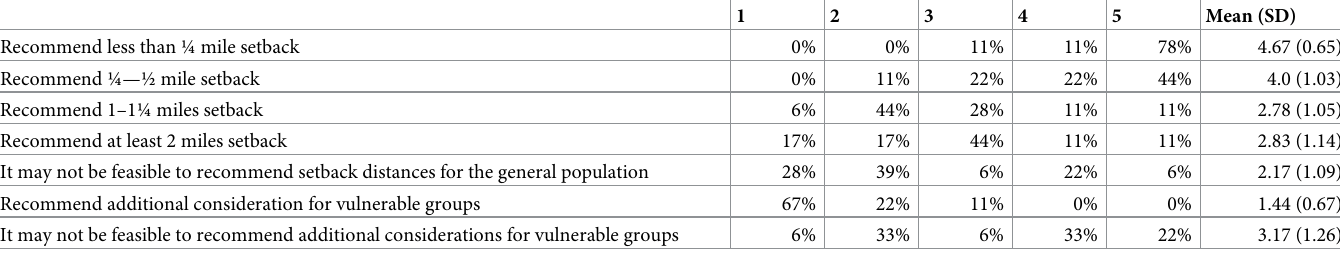
Table 4. Distribution of panelists’ levels of agreement with statements used in Round 3 and median